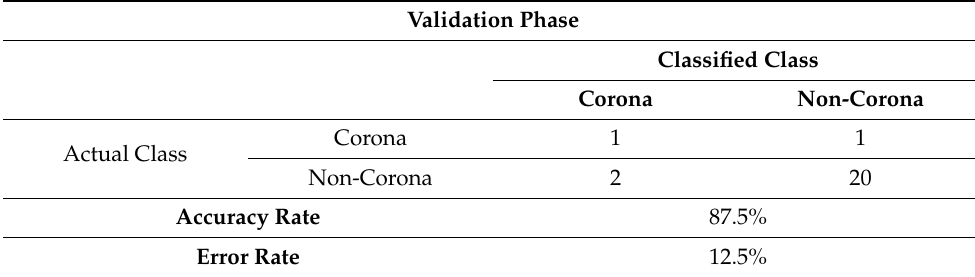
Table 8. Confusion matrix for validation phase—time domain corona fault